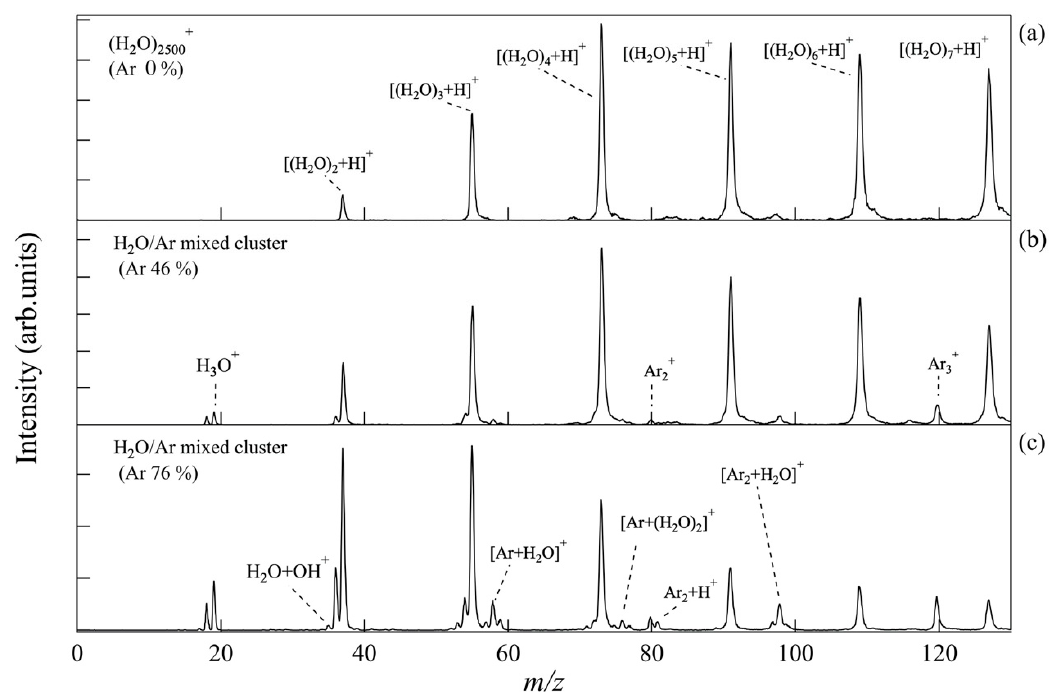
Figure 6. Mass spectra of ions detected from Ag sample under bombardment with the water cluster (H 2 O) 2500+ ion ( a ) and water/Ar mixed cluster ions ( b , c ). The selected mass of the clusters are 45,000 Da and E / m is 0.11 eV/amu.